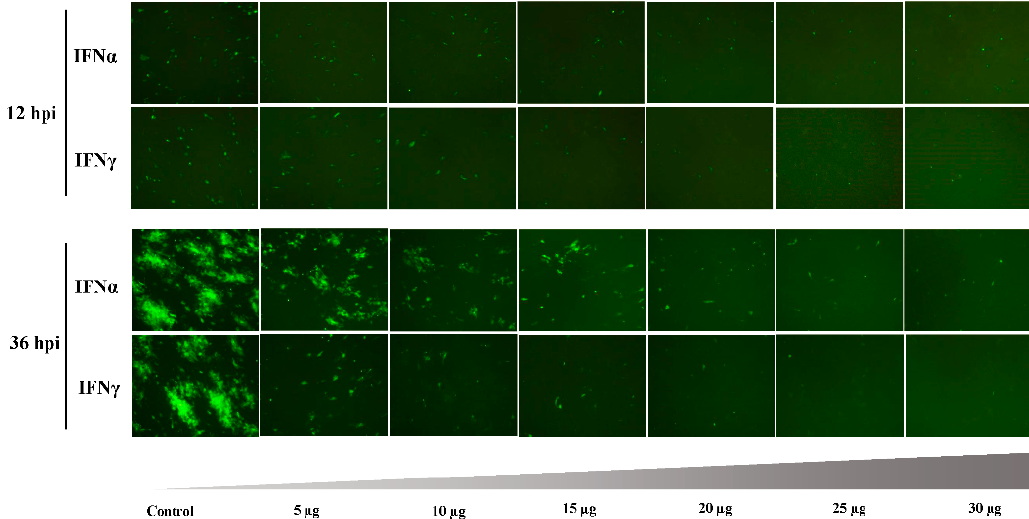
Figure 4. Dose-dependent inhibition of DPV replication by IFN α and IFN γ is shown by green fluorescence (Magnification 400×). To study the inhibitory effect of IFNs against DPV, DEF cells were seeded in 24-well plates at 10 5 cells/well, treated with indicated IFN α or IFN γ , at 5, 10, 15, 20, 25 and 30 µg or left untreated (control); 12 h later, the cells were infected with DPV (10 4 TCID 50 /well). At 12 hpi and 36 hpi, green fluorescence was examined via fluorescence microscopy, respectively (original magnification × 400).